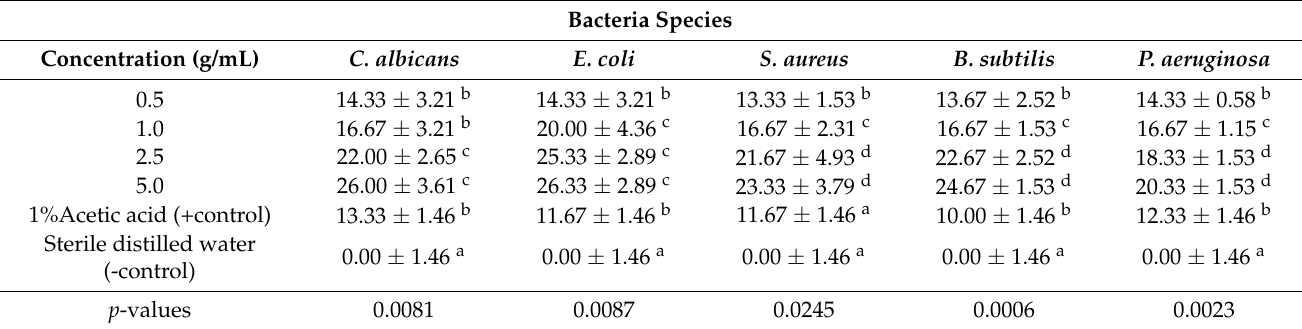
Table 2. The mean inhibition zones (mm) of BSF chitosan against selected pathogenic microbes. Bacteria